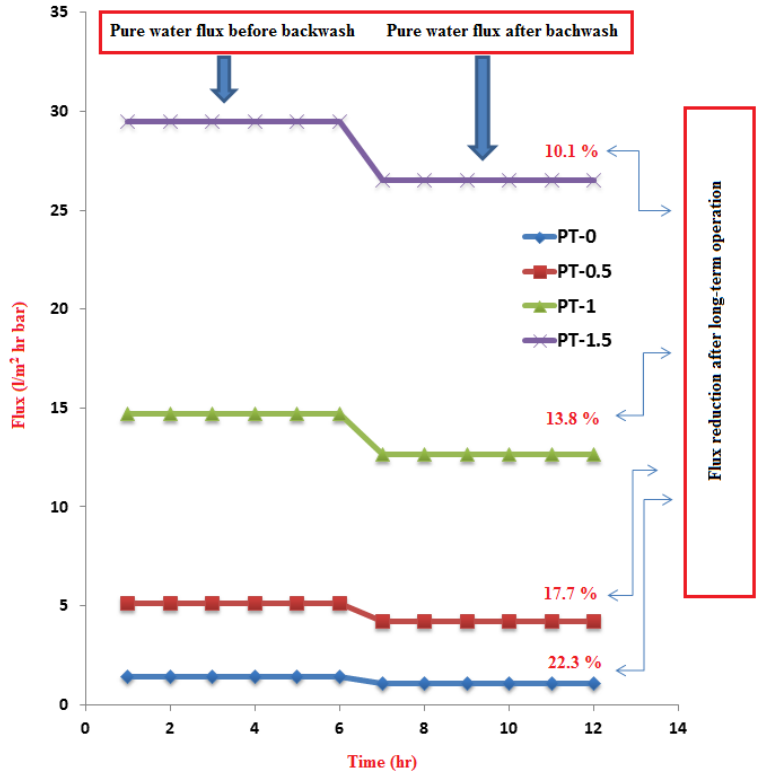
Figure 9. Flux of pure water before and after backwashing for 12 h at pressure of 2 bar and percentage of flux reduction of the PVC membranes at different TiO 2 amounts: (PT-0) 0 gm TiO 2 ; (PT-0.5) 0.5 gm TiO 2 ; (PT-1) 1 gm TiO 2 ; and (PT-1.5) 1.5 gm TiO 2 .